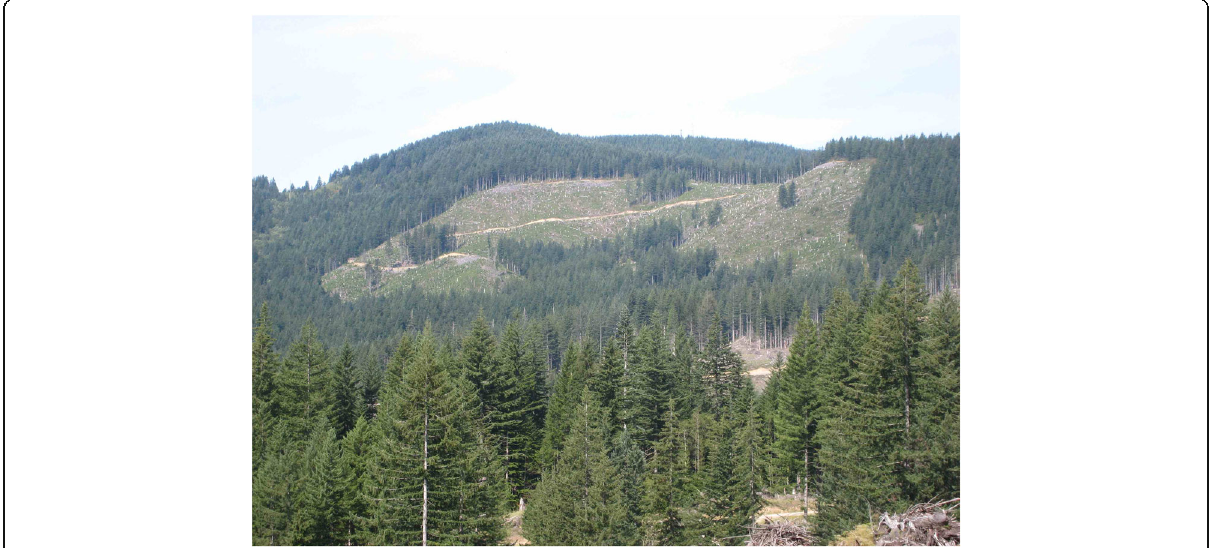
Fig. 6 Example of variable retention harvest as practiced across > 500,000 ha of lands managed by the Washington State Department of Natural Resources. Variable retention has been the DNR ’ s primary approach to regeneration harvests since the late 1990s, with an overall objective of maintaining and promoting large structurally unique trees, snags, and down wood over time. The minimum retention of 20 trees per hectare (mix of dispersed and aggregated pattern depending on individual unit) occurs in addition to that in riparian buffers, unstable slopes, gene pool reserves, old-growth deferrals, and other conservation-driven